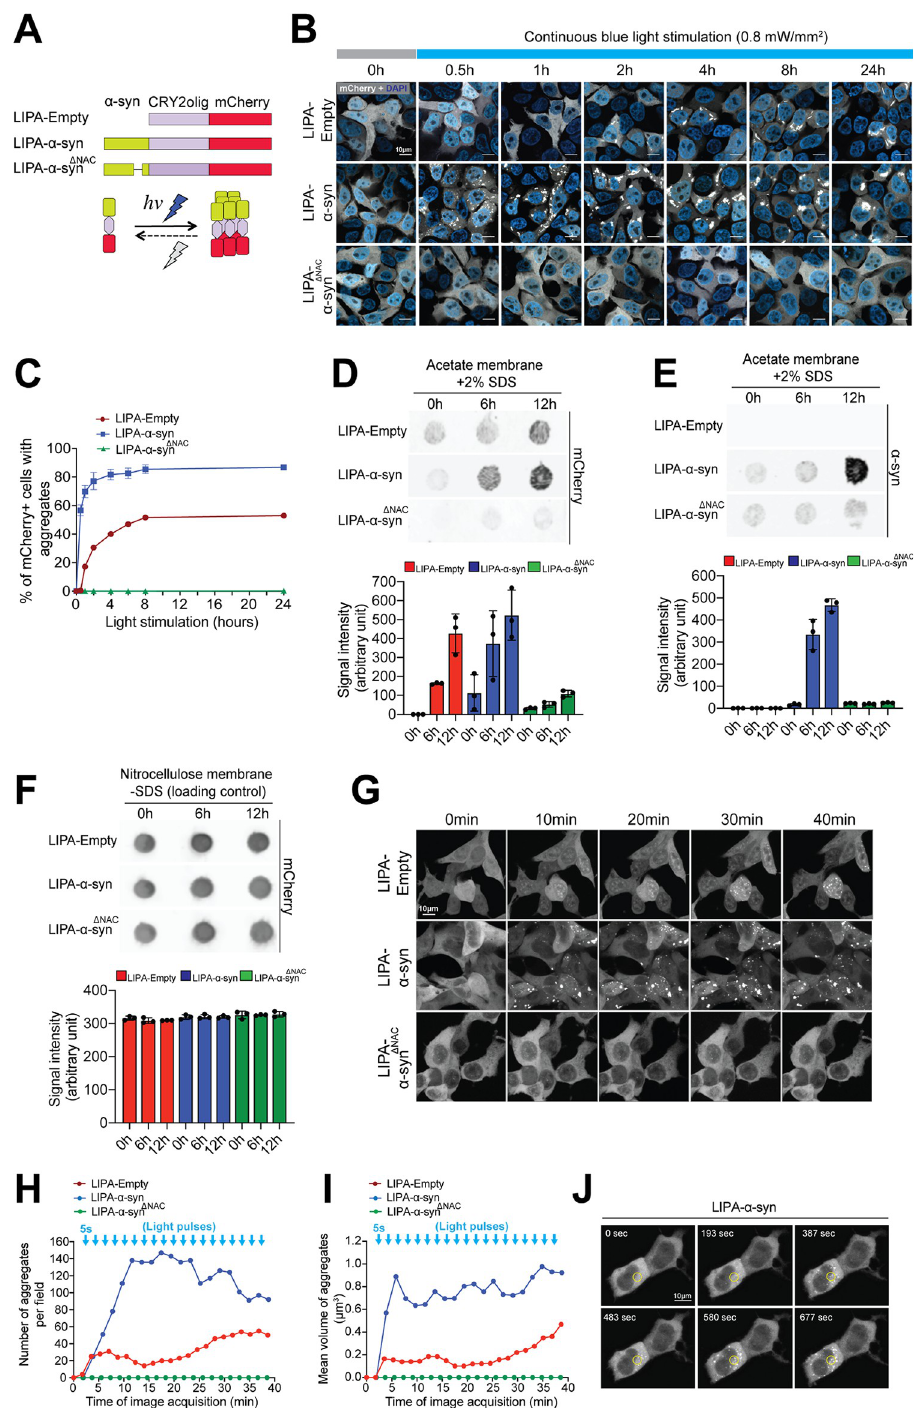
Fig 1. The LIPA system allows for long-term induction and real-time monitoring of α -syn aggregation. ( A ) Schematic representation of the LIPA constructs. Under blue light stimulation, the LIPA system induces robust and reversible protein clustering. ( B ) Representative confocal images of HEK-293T cells overexpressing the LIPA constructs exposed to continuous blue light stimulation (0.8 mW/mm 2 ) for different time points up to 24 hours (scale bar = 10 μ m). ( C ) Estimation of the percentage of mCherry-positive HEK-293T cells exhibiting LIPA aggregates at different time points during continuous blue light stimulation (220–250 cells/condition/time point; n = 3). The data are presented as the means ± SEM. ( D and E ) Filter retardation assay showing the time course of LIPA-Empty